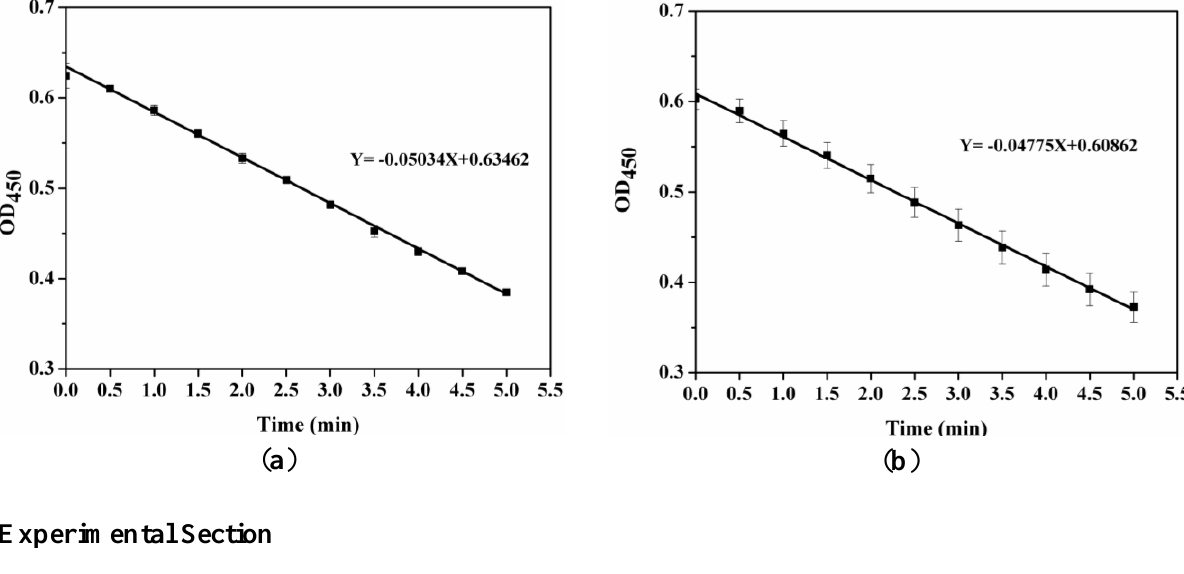
Figure 8. Enzyme activity curves of ( a ) pure LSZ; ( b ) LSZ from LSZ-PLLA